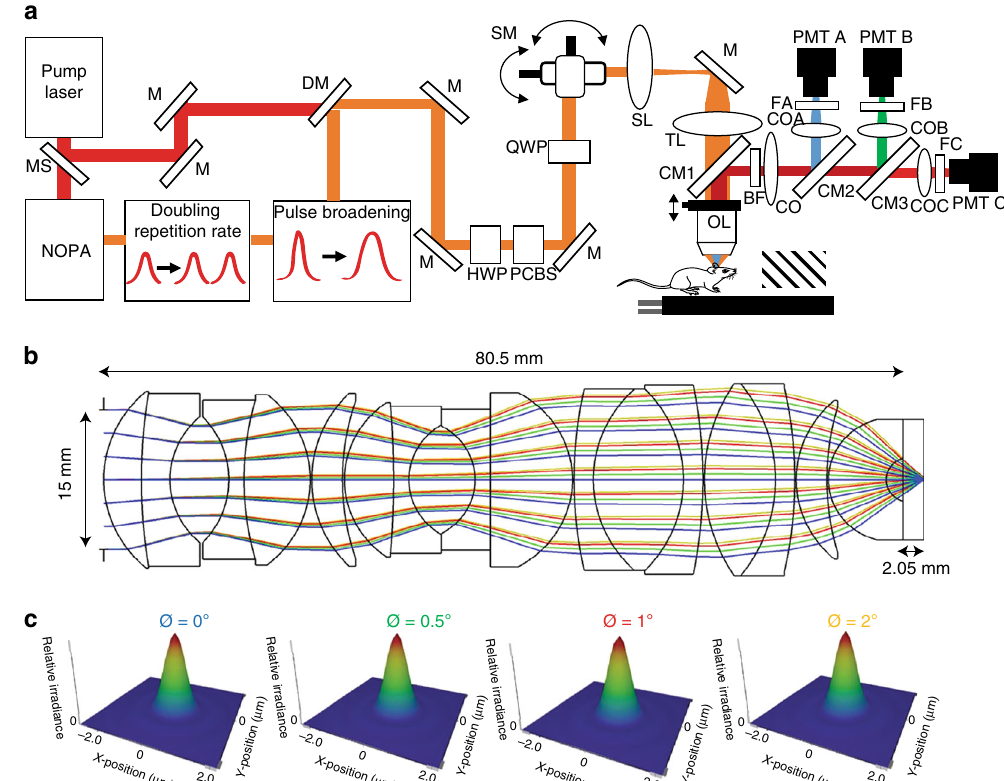
Fig. 1 Schematic of upright three-photon microscope and layout of the modeled objective lens. a Femtosecond laser pulses from the pump laser (1045 nm) were used to pump the noncollinear optical parametric ampli fi er (NOPA) to obtain 1300 nm excitation wavelength. The pulse width was elongated using a two-prism pair system and the repetition rate was doubled to 800 kHz by adding a delay line. Power control of laser pulses was performed using a combination of a half-wave plate (HWP) and polarizing cube beam splitter (PCBS). A quarter-wave plate (QWP) was used to control the polarization state of the laser pulses to maximize third harmonic generation (THG) signal on the mouse brain. Laser beams were scanned by a pair of galvanometric scanning mirrors (SM), which were then imaged on the back aperture of a 1.05 NA, 25× objective lens (OL) by a pair of a scan lenses (SL) and a tube lens (TL). Mice were placed on a two-axis motorized stage. The objective was placed on a one-axis motorized stage. Emitted light was collected by a dichroic mirror (CM1, FF705-Di01,Semrock; CM2, Di02-R488, Semrock; CM3, FF555-Di03, Semrock), collection optics (CO), laser blocking fi lters (BF, FF01-670/SP), and nonlinear imaging fi lters (FA, FF01-433/24-25, Semrock; FB, FF03-525/50, Semrock; FC, FF01-630/92) and corresponding collection optics (COA, COB, and COC) for each photomultiplier tube (PMT A, PMT B, and PMT C). To make laser ablation marks at different depths of cortex, the output of the pump laser (1045 nm) was sent to the microscope using a mechanical shutter (MS) and a long pass dichroic mirror (DM, Di02-R1064, Semrock). b The optical layout of the objective modeled in Zemax at 1300 nm. The clear aperture of the objective was 15 mm and the working distance was 2.05 mm while using seawater as a sample. c Huygens point spread function results for 4 different scanning angles (0°, 0.5°, 1°, and 2°) on the objective. Numerical apertures in all cases were 1.02 and Strehl ratio values decreased from 0.997 to 0.979 while increasing the scanning